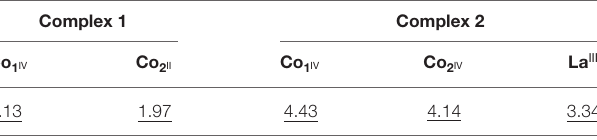
TABLE 3 | Bond valence sums b for complexes 1 and 2 a